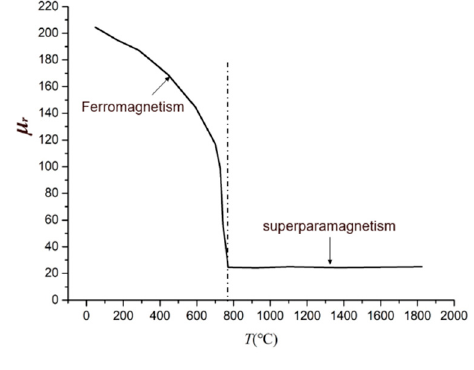
Figure 5. 409L T-permeability curve.